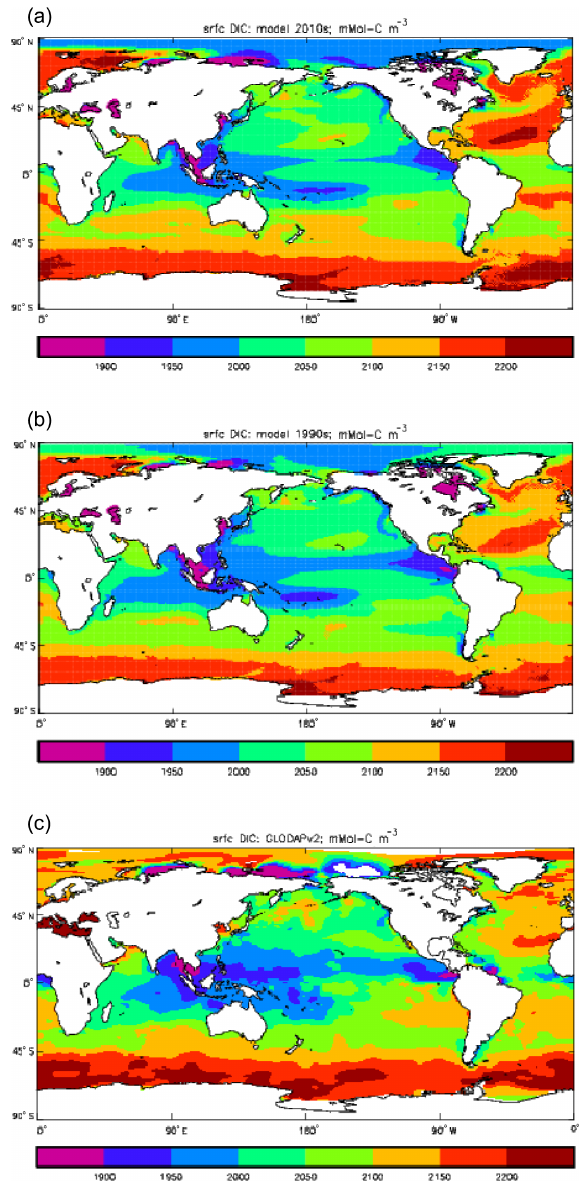
Figure 9. Surface concentration of dissolved inorganic carbon (mMolCm − 3 ): (a) model field averaged over model years 2010– 2019; (b) model field averaged over model years 1990–1999; (c) the gridded field from the GLODAPv2